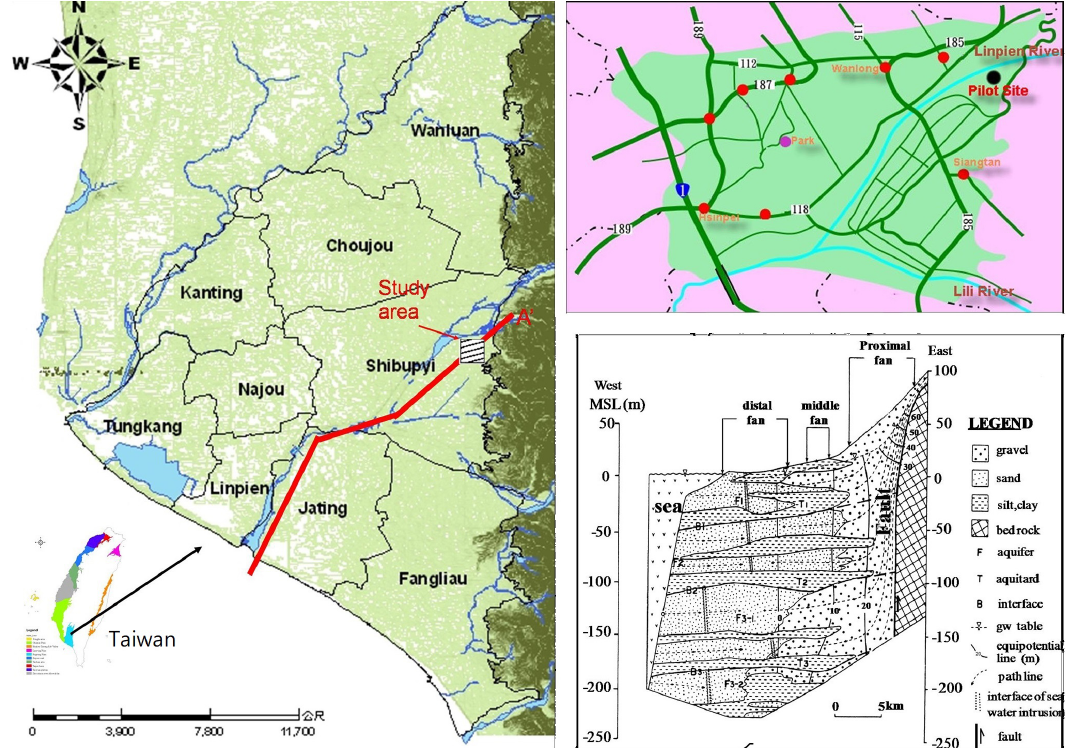
Figure 1. Location of the study area and hydrological profile in the study area (NPUST, 2016).